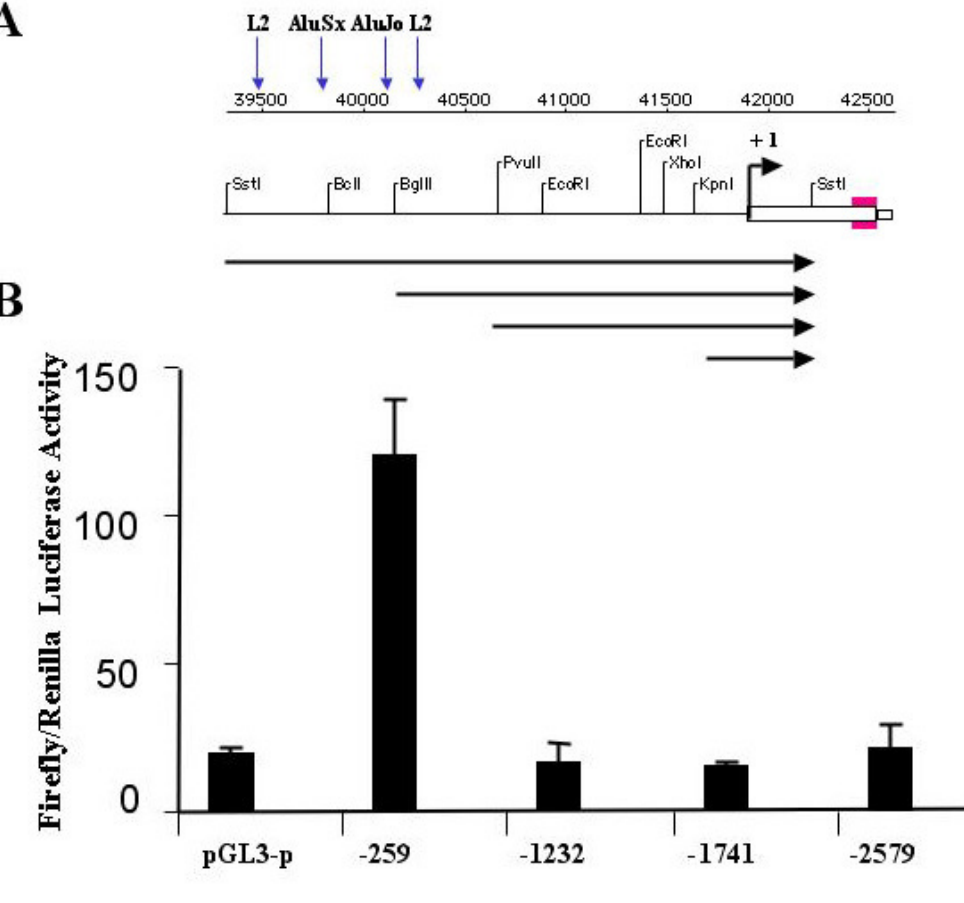
FIGURE 5. Design and transcriptional activity of hSERCA2 5’-regulatory region/luciferase constructs. (A) Restriction mapping of the 5’-regultory region of the human SERCA2 gene is indicated. Deletion constructs containing -259, -1,232, -1,741, and –2,579 bp are indicated with arrows. The transcription initiation site is indicated with (+1). The positions of the repeat sequences L2 and Alu are shown with arrows on top of the bar indicating the nucleotide position in the genomic clone RPC 13-305I20. (B) Neonatal rat cardiac myocytes were transfected with SERCA2/Luc constructs using Lipofectamine as described under Methods. The transcriptional activity of the hSERCA2/Luciferase constructs is shown as the normalized ratio of Firefly/Renilla luciferase activities (mean+/-S.D.). The pGL3-promoter plasmid was used to compare relative transcriptional